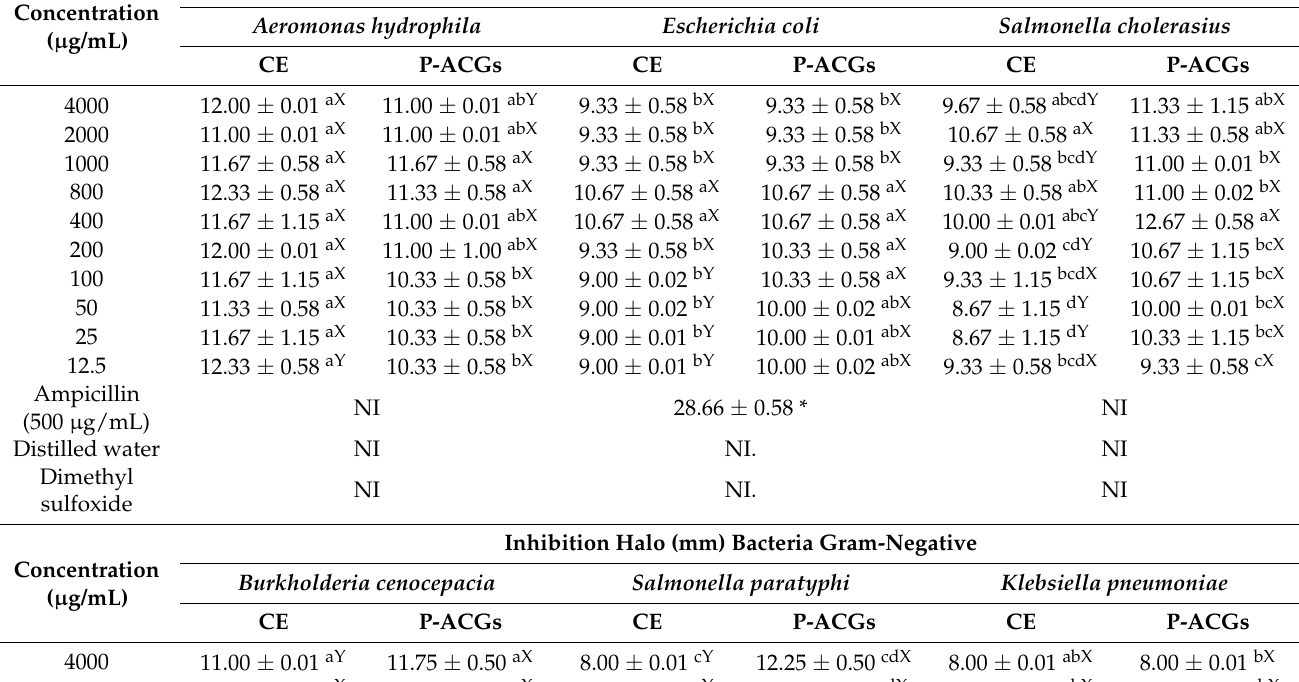
Table 2. Antibacterial activity of the crude extract (CE) and purified acetogenins (P-ACGs) from endosperm of A. muricata seeds against several Gram-negative bacteria.